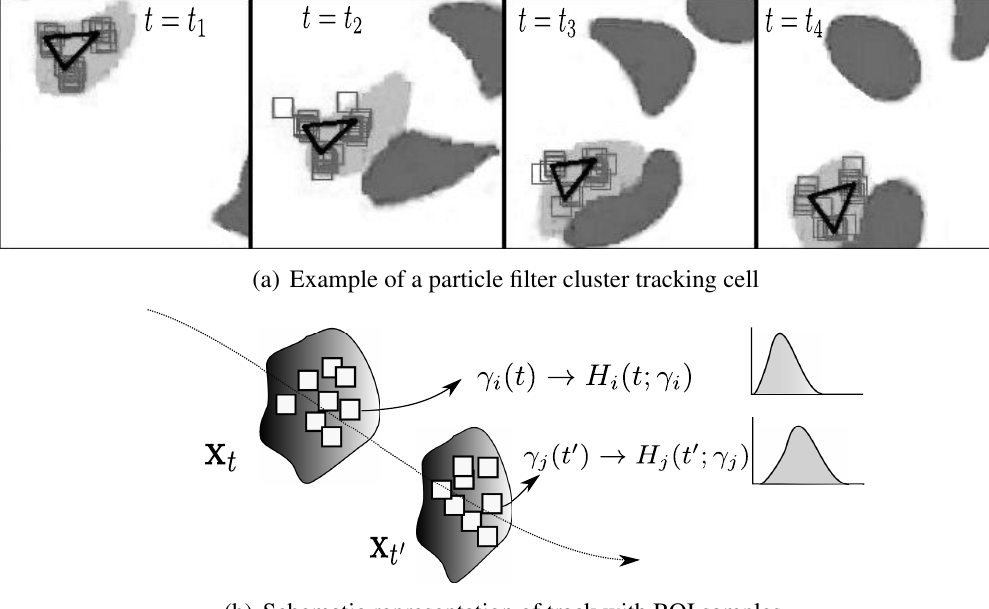
(b) Schematic representation of track with ROI samples. Figure 1: Concepts for particle filter tracking of cells: (a) representative particle samples of individual regions of interest (ROI) of the image frame at time t , (b) diagram of particle filter ROI samples along the trajectory from x t to x t + 1 , and illustrating histograms obtained for each particle ROI. Observations are compared against a reference histogram, obtained upon particle node creation. Samples are obtained via Sequential Importance Sampling (SIR) as